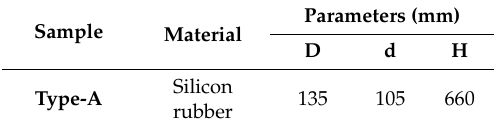
Table 2. Structure parameters of the tested insulators.